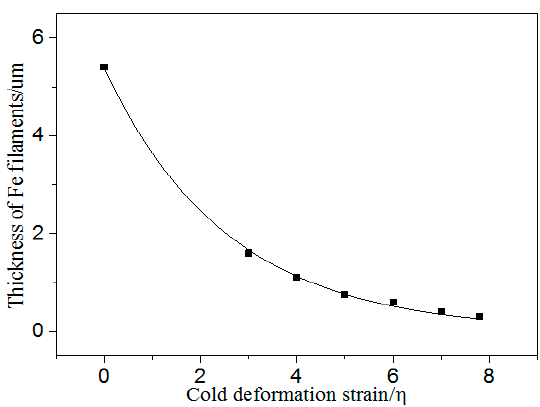
Figure 3. Thickness of the Fe phase in the Cu–14Fe vs. the cold deformation